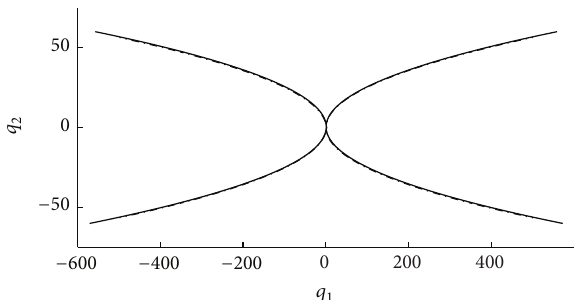
Figure 13: The dependencies for minimal control time from 𝛼 2 at different values of 𝛼 1 for 𝑝 󸀠 = 1 . Logarithmic scale used for ordinates.